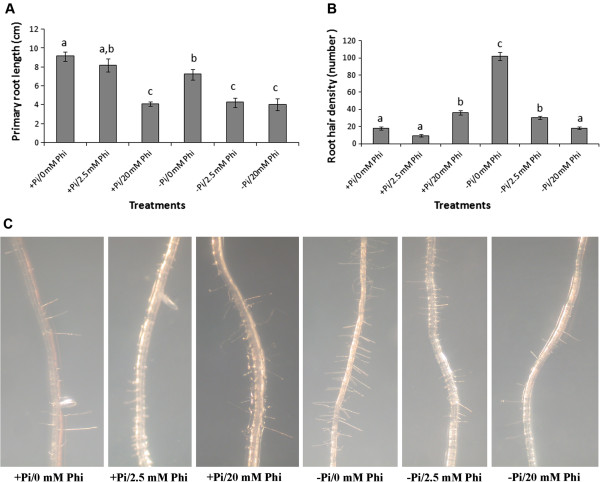
Inhibitory effect of phosphite on primary root length and root hair density under phosphate deficiency. The effect of phosphite (Phi) treatments on primary root length (A) and root hair density (B) of Arabidopsis thaliana ecotype Columbia (Col-0) grown under different phosphate (+Pi and -Pi) regimes. (A) Primary root length measured 7 days after transferring the seedlings to different Pi (+Pi; 1.25 mM and –Pi; 0 mM) and Phi media. Data are the means of 10 roots assessed per treatment with standard errors and bars with the same letter are not significantly different according to Tukey HSD test. (B) Root hair density (number) 7 days after transferring the seedlings to different Pi (+Pi and –Pi) and Phi medium. Root hair density was determined as the number of hairs in a 5 mm root segment, 2.5 mm from the root tip, and each bar represents the mean of six plants with standard error bars and bars with the same letter are not significantly (P > 0.05) different according to Tukey HSD test. (C) Shows the effect of different Phi concentration on root hair formation in seedlings grown in + Pi or –Pi media.